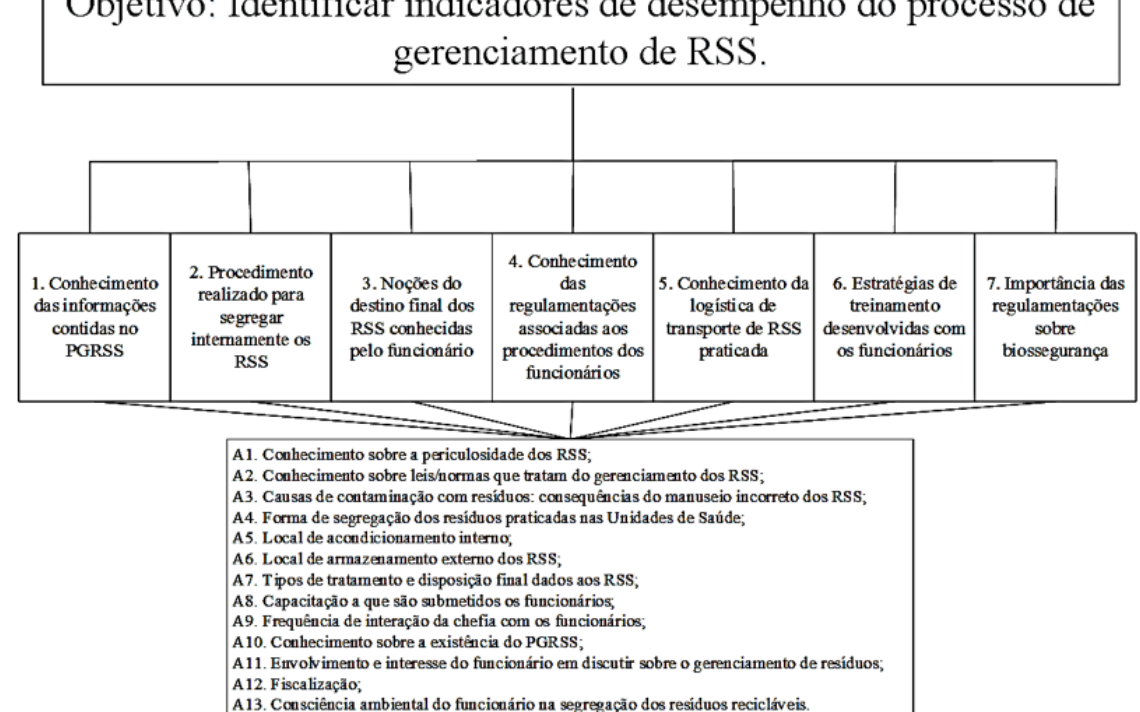
Figure 2 - Hierarchical structure